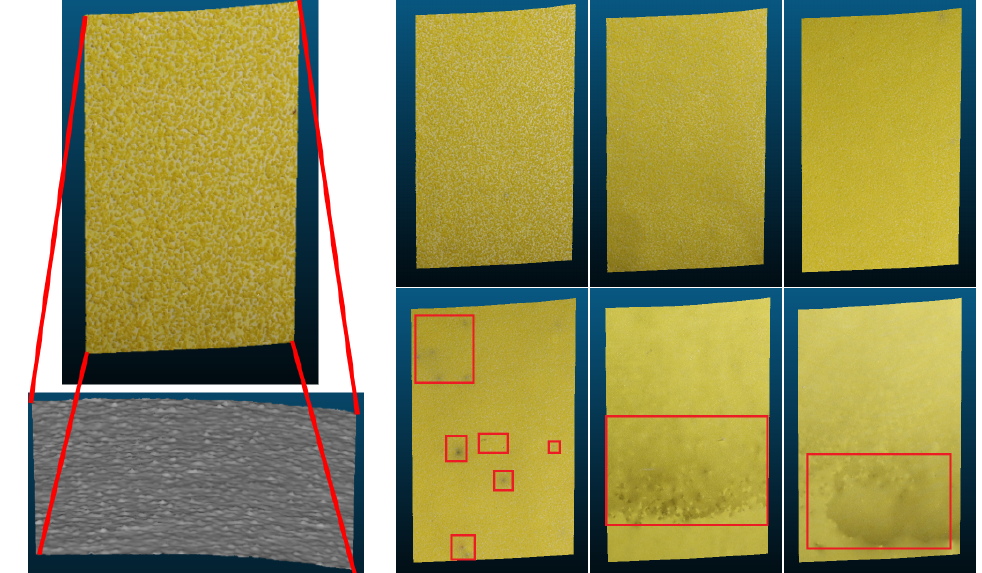
Figure 7. SfM reconstructions of the seven grit sizes at 1.7 m range. (Leftmost) P40 with close up of the geometry. (Top row) P60, P80, P100 and (bottom row) P120, P180, P240. The P120, P180 and P240 reconstructions show darker areas with erroneous color texture. These areas are marked with